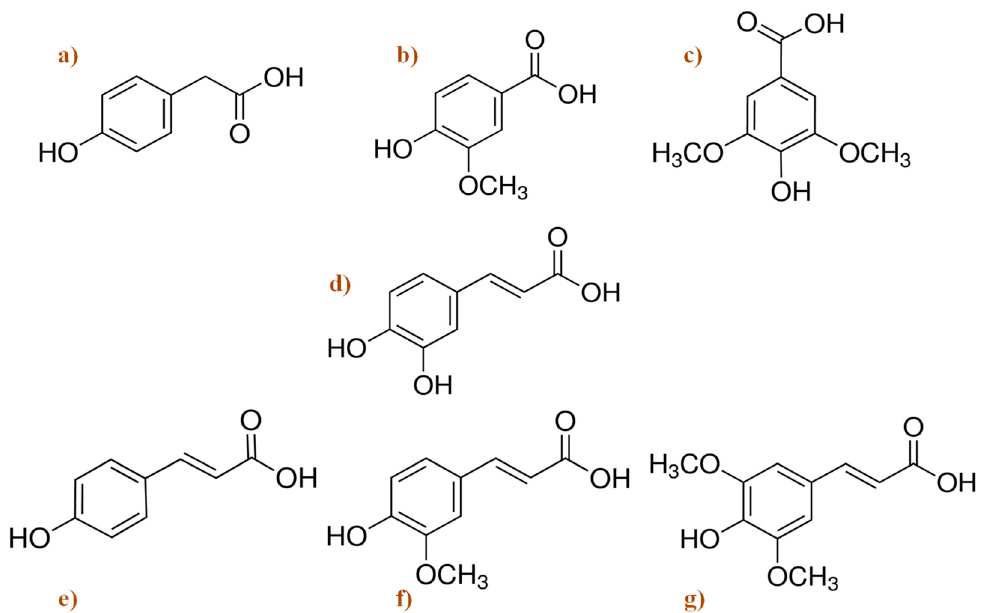
Figure 4. Chemical structure of the main phenolic acids found in beer. ( a ) 4-hydroxyphenylacetic acid; ( b ) vanillic acid; ( c ) syringic acid; ( d ) caffeic acid; ( e ) p-coumaric acid; ( f ) ferulic acid; and ( g ) sinapic acid [109].